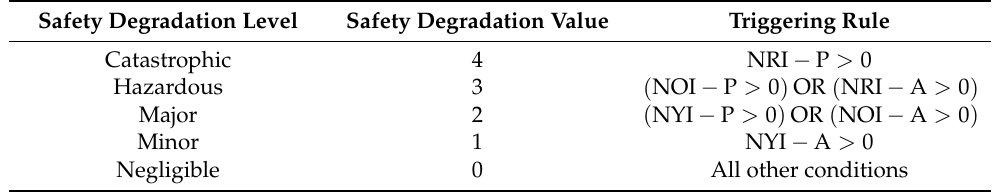
Table 8. Safety degradation metric.